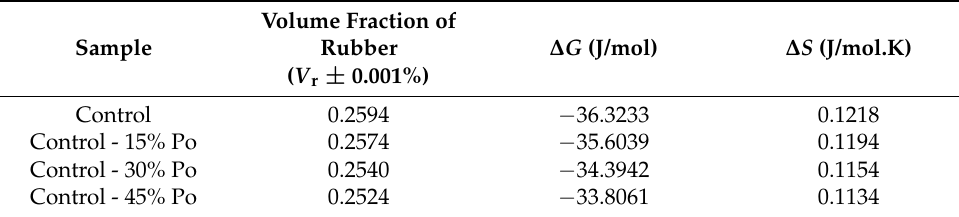
Table 4. The volume fraction of rubber from the swelling test and thermodynamic parameters ( ∆ G and ∆ S ) from the Flory–Huggins equation